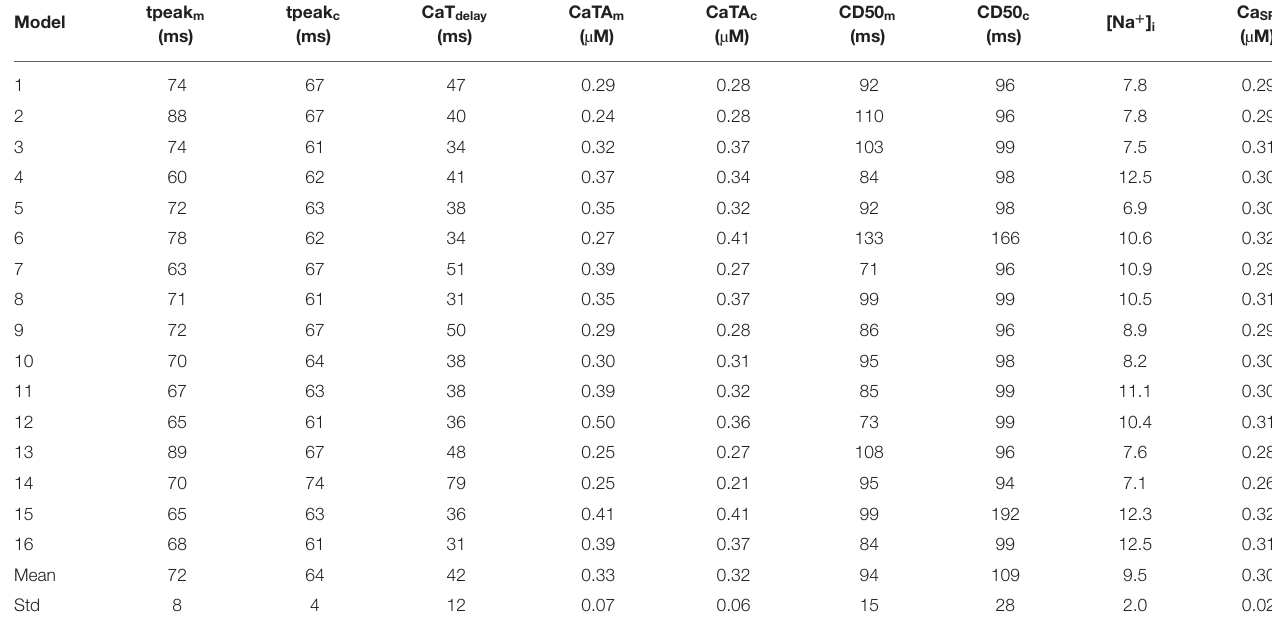
TABLE 4 | Values of the Ca 2 + metrics obtained from the control population.